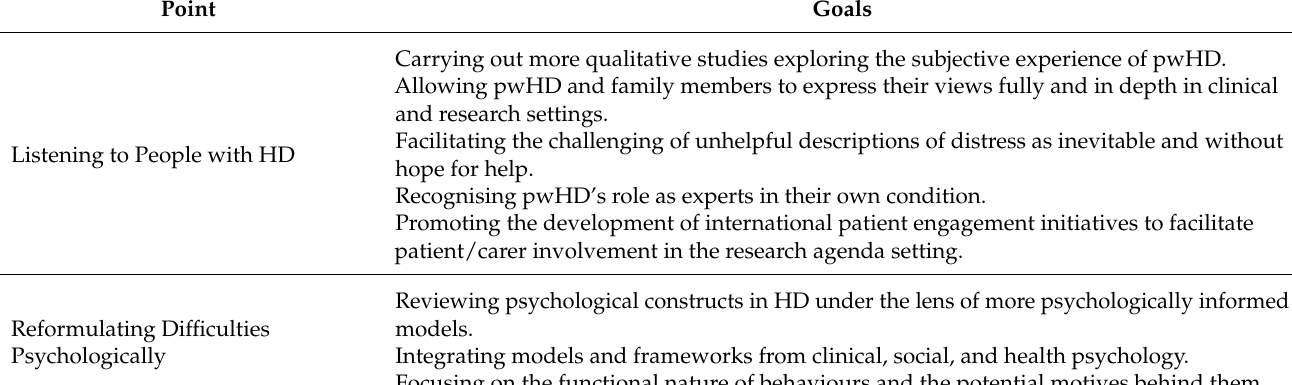
Listening to People with